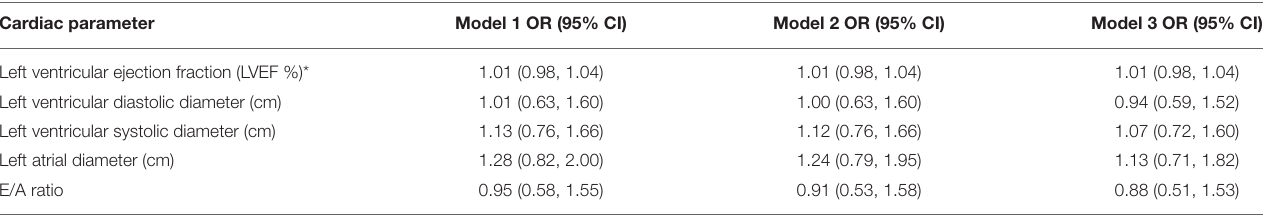
TABLE 2 | Multivariable logistic regression demonstrating the odds ratio of neglect per unit increase in the transthoracic echocardiogram variable ( N = 218). Cardiac parameter